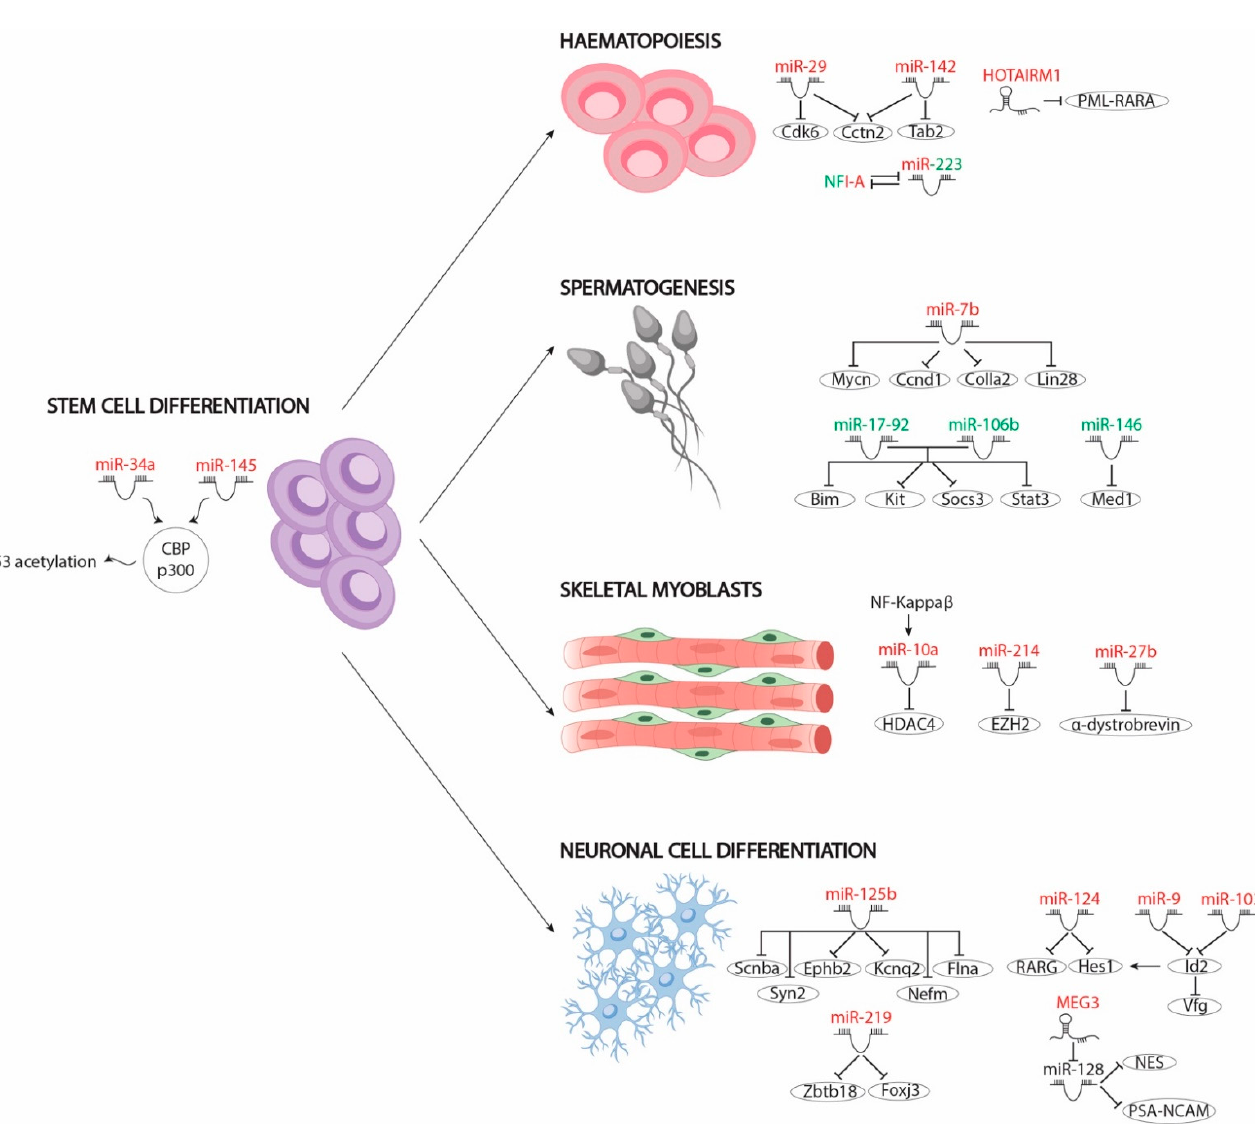
Figure 2. Schematic representation of the different non-coding RNAs involved in RA-regulated differentiation pathways, including stem cell differentiation, haematopoiesis, spermatogenesis and skeletal muscle and neuronal cell differentiation. MicroRNAs and lncRNAs that are upregulated after RA administration are depicted in red while those that are downregulated after RA administration are depicted in green.